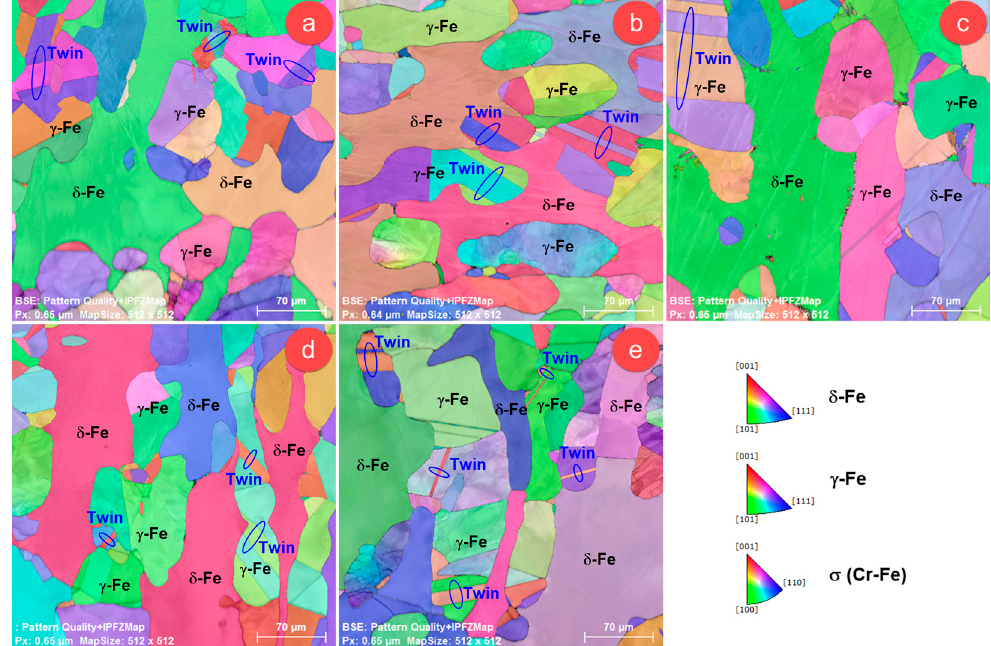
Figure 5. Inverse Pole Figure in respect to z sample axis (IPFZ) images of both δ -Fe and γ -Fe phases for: ( a ) as-forged UNS S32750/1.4410/F53 SDSS alloy; ( b ) solution-treated (ST) at 800 °C for 0.6 ks; ( c ) ST at 900 °C for 0.6 ks; ( d ) ST at 1000 °C for 0.6 ks; ( e ) ST at 1100 °C for 0.6 ks.